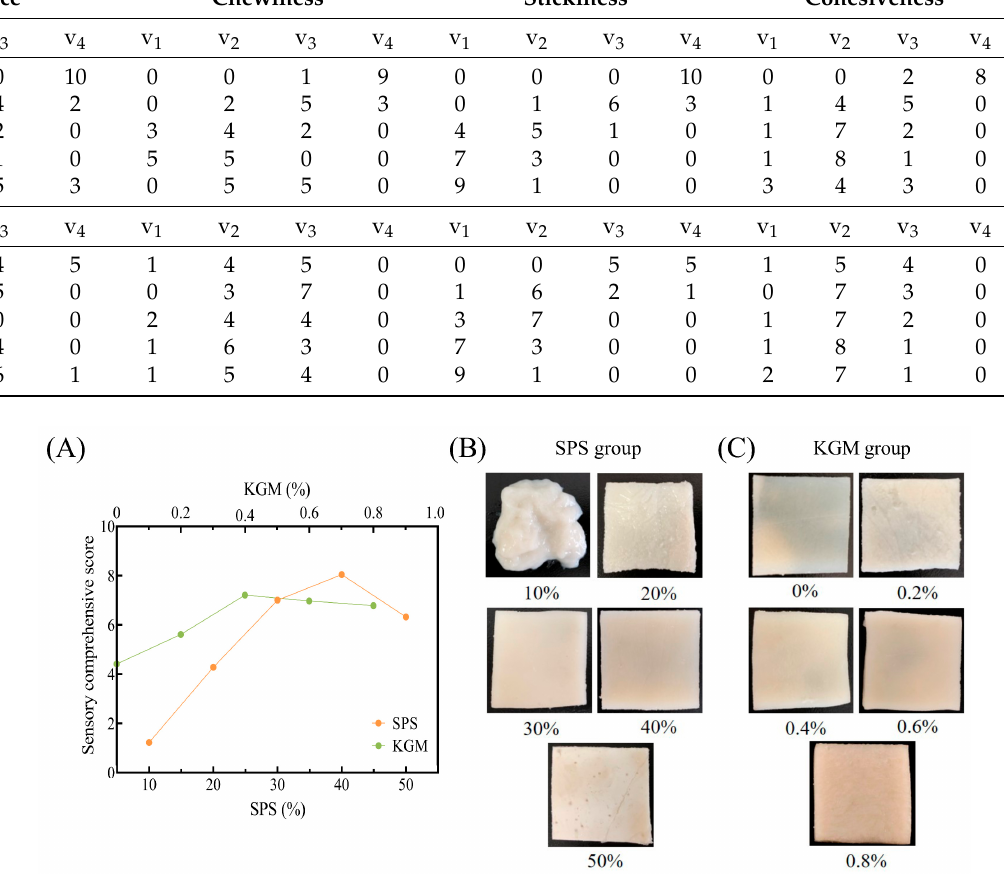
Figure 2. The SCS ( A ) and photographic images ( B , C ) of the plant-based pork rinds containing different SPS and KGM concentrations.